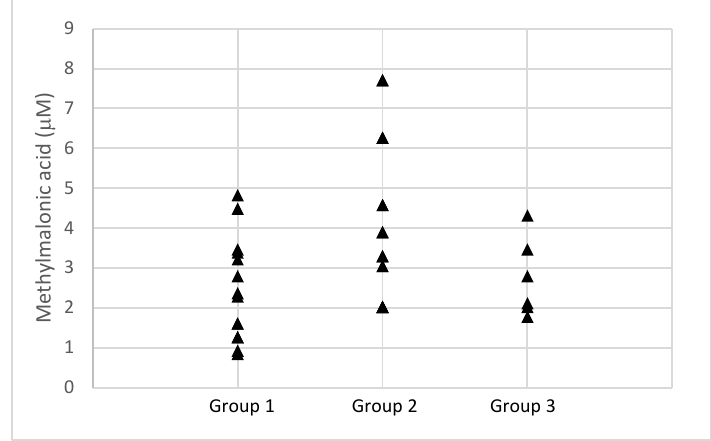
Figure 2. Methylmalonic acid level measurement by LCMS in PD patient sera (Group 1—PD patients not treated with levodopa; Group 2—PD patients treated with levodopa; Group 3—Healthy